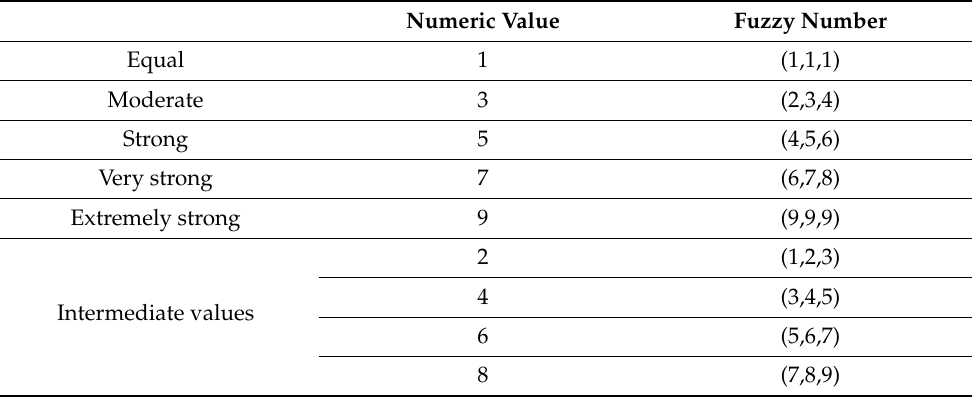
Table 5. The fuzzy scale of relative importance [110–112].